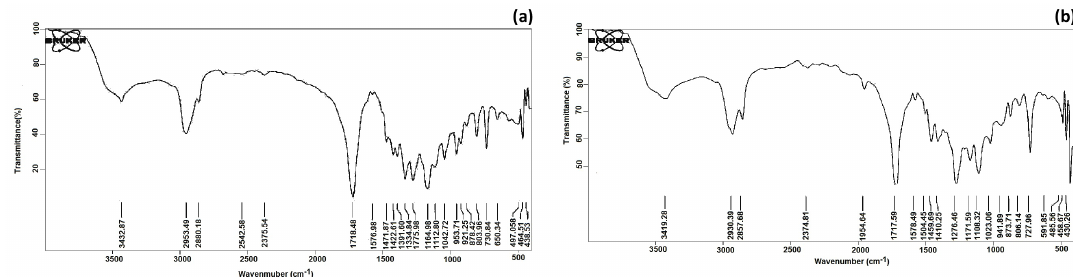
Fig. 1 a. FTIR of PBSBT copolyester; b. FTIR of PBSeBT